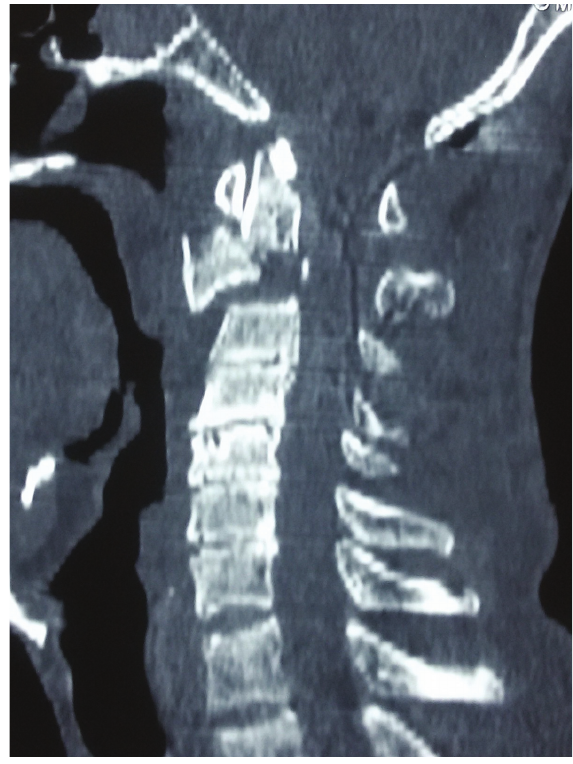
Figure 7. CT spine showing good reduction of the posterior and the spino-laminar lines and normal